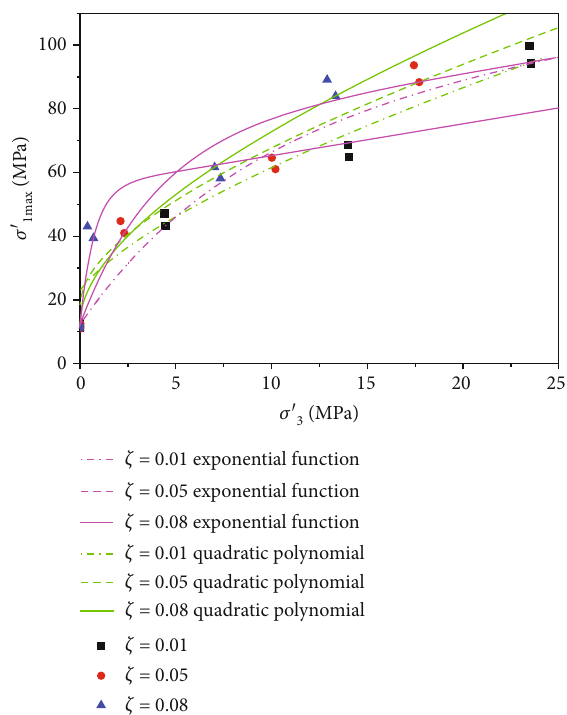
Figure 6: Triaxial compressive strength of water-saturated coal samples and the fi tted curves of two yield criteria under di ff erent pore pressures.